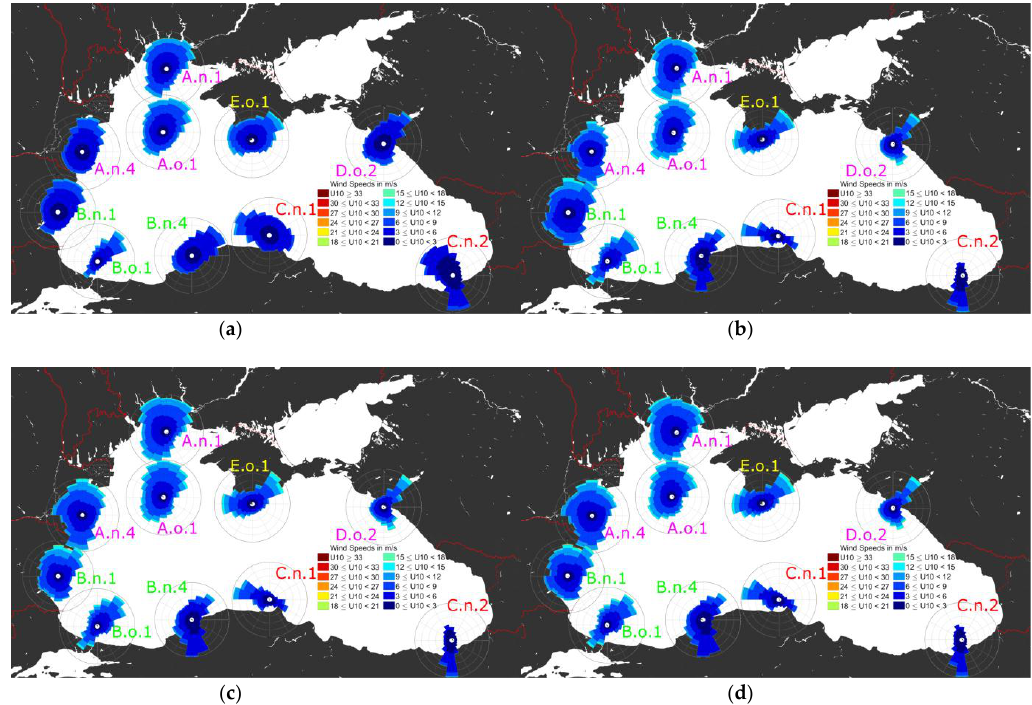
Figure 9. Wind roses corresponding to 30-year of data (1981–2010) coming from: ( a ) ECMWF ERA-Interim and ( b ) EURO-CORDEX Evaluation; 30-year interval (2021–2050) coming from: ( c ) EURO-CORDEX RCP4.5 scenario and ( d ) EURO-CORDEX RCP8.5 scenario.